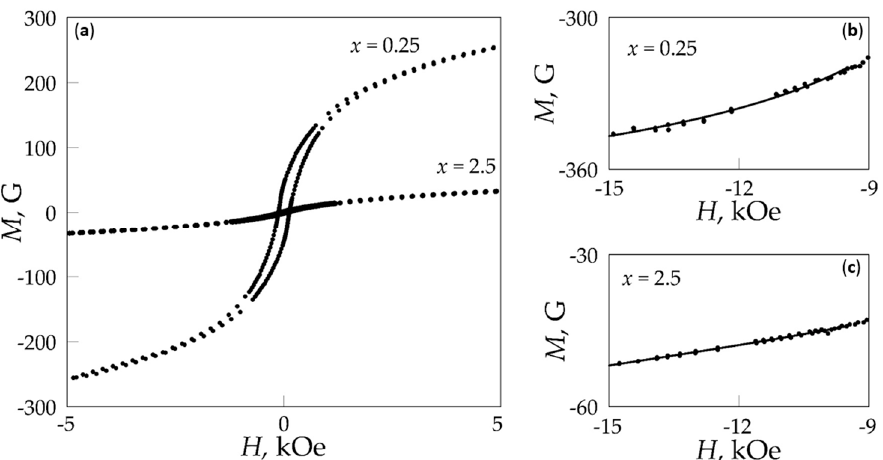
Figure 3. ( a ) The measured magnetic hysteresis loops for the composite samples of BaFe 12 − x Ti x O 19 with x = 0.25 and x = 2.5 are provided to demonstrate the fittings by Equation (3) at the high-field region for samples with ( b ) x = 0.25 and ( c ) x = 2.5.